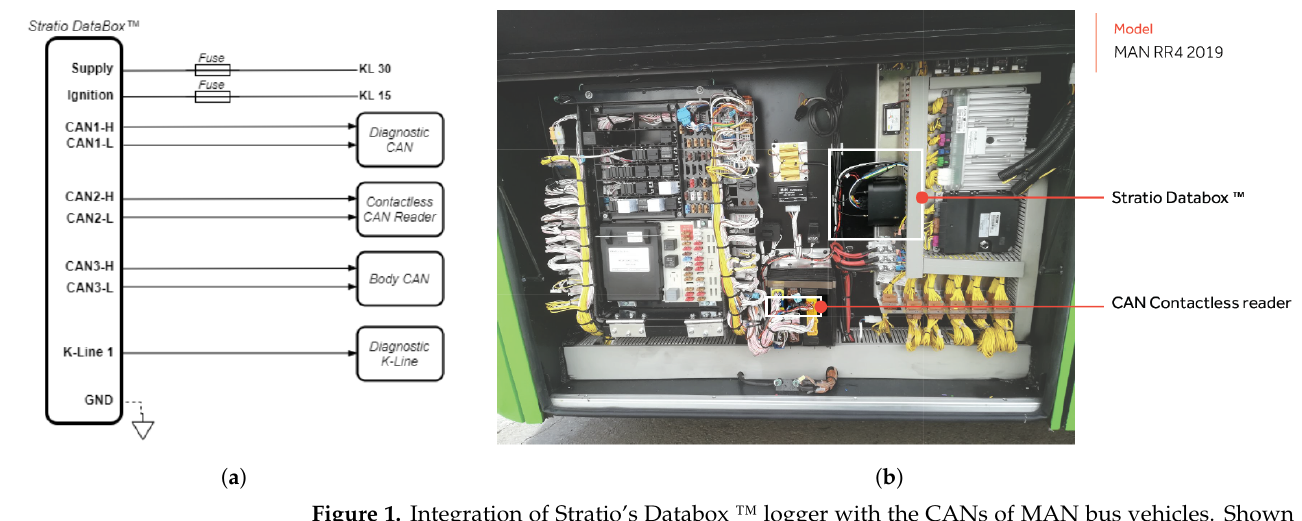
Figure 1. Integration of Stratio’s Databox ™ logger with the CANs of MAN bus vehicles. Shown is ( a ) the connection scheme of the logger with different CAN buses and other connections on the vehicle, and ( b ) a photograph showing the logger installed onboard a